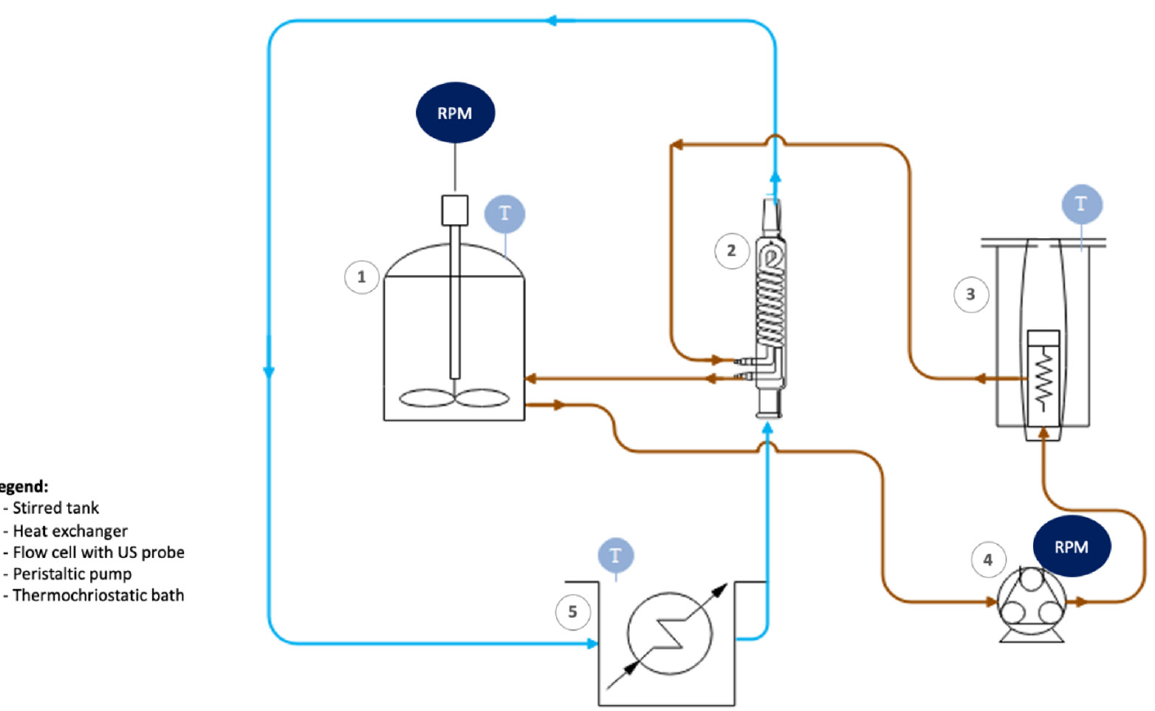
Figure 1. Schematic representation of the recirculation system for GOn production by high-power ultrasonication.